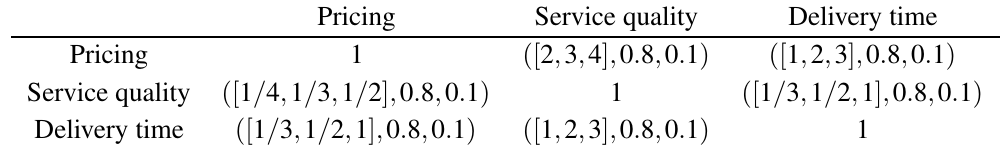
Table 3: Generalized intuitionistic fuzzy pair-wise comparison matrix